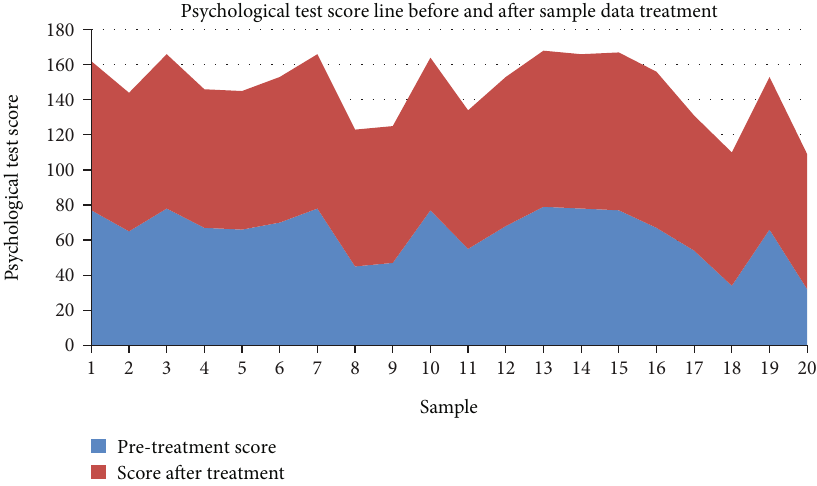
Figure 6: Broken line chart of psychological test scores of sample data before and after